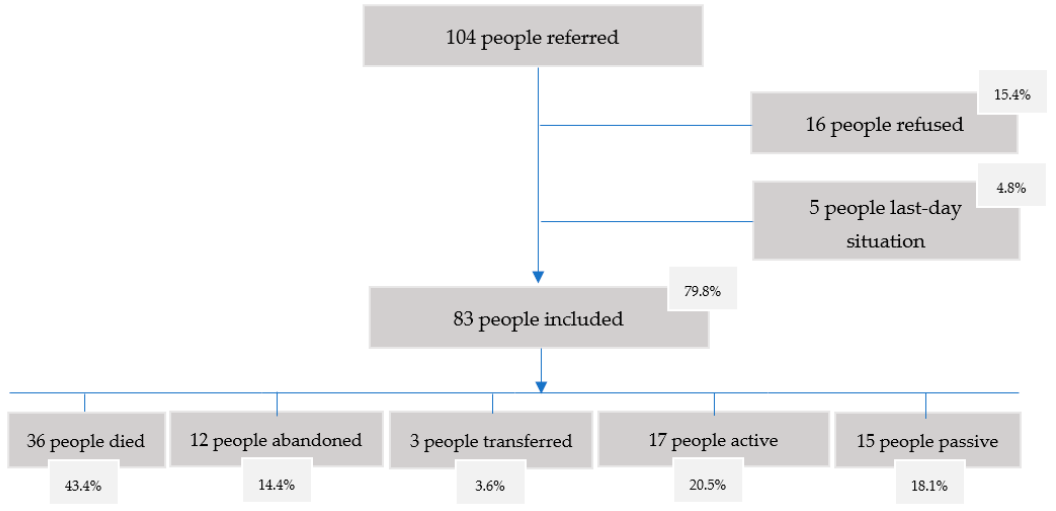
Figure 1. Inclusion process flowchart.